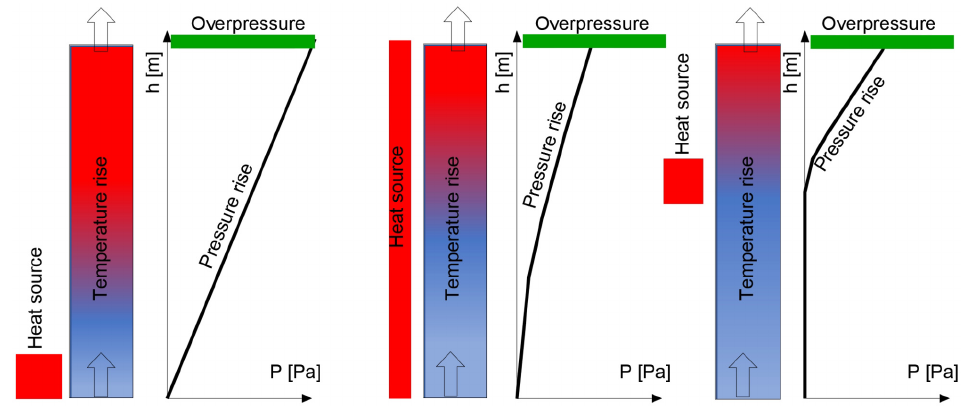
Figure 3. Distribution of pressure and temperature in a room [22].